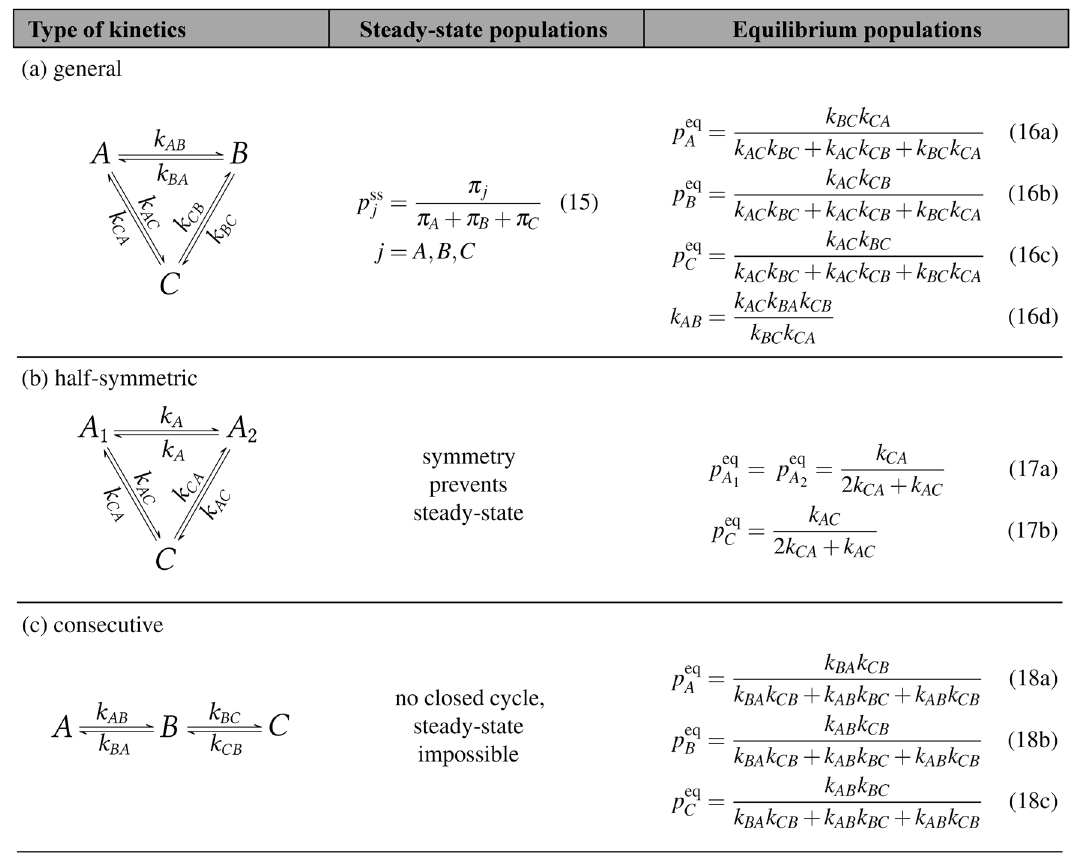
Table 1. Three-state spin kinetics and its special